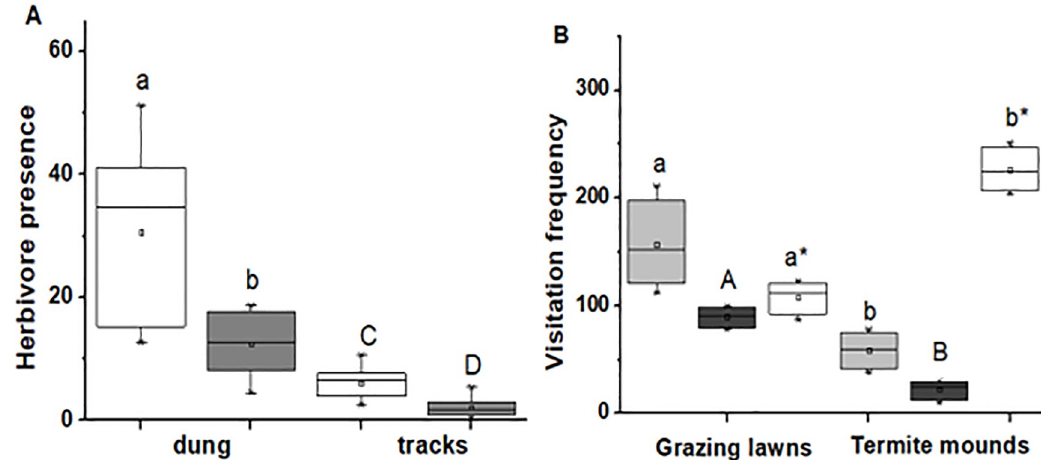
Fig 6. A. Herbivore presence averaged using dung between grazing lawns (white box vs controls (grey box) and herbivore presence using tracks between grazing lawns (white box) vs controls (grey box). Capital letter and small letters has been used to differentiate dung and tracks. B. Herbivore visitation frequency, hartebeest (grey box), reedbuck (black box) and roan antelope (white box) in grazing lawns and termite mounds. Capital letters indicate significant differences between reedbuck visitations, small letters with asterisk compare Roan antelope visitation and small letters compare means of hartebeest visitations. Boxplots show the mean (a square within boxes) and ranges from 25% and 75% quartile, and the tips of the whiskers indicate standard deviation. Boxes with different letter(s) are significantly different by Fisher LSD at P =